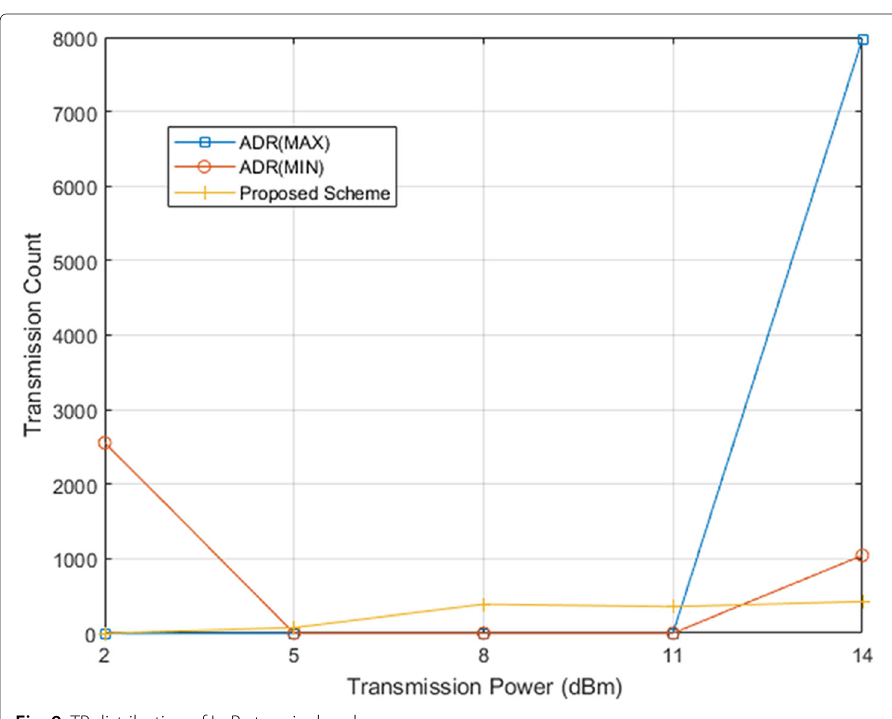
Fig. 9 TP distribution of LoRa terminal nodes